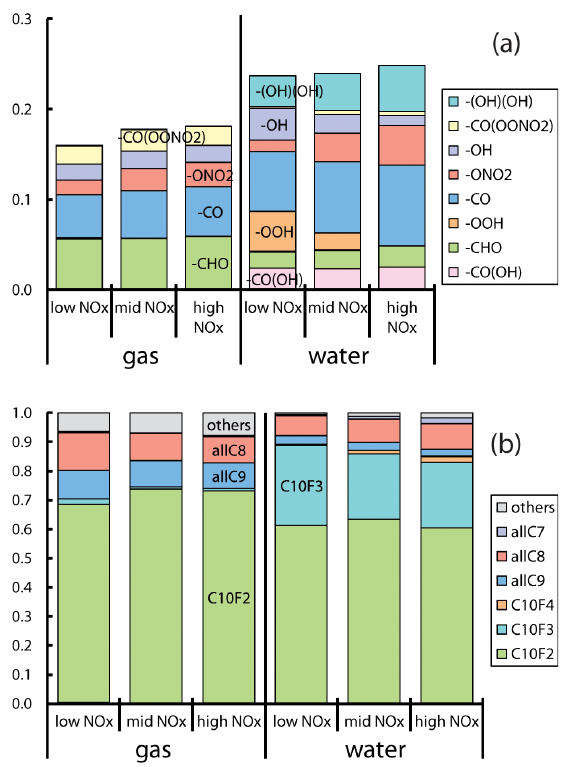
Fig. 5. At N τ = 2, simulated distribution in gaseous and aqueous phase of organic moieties ratio ( R OF / C , panel a ) and functional- ization (panel b ) for a cloud water content during the oxidation of α -pinene. C m F n category merges species with m carbon atoms bearing n functional groups. The precursor and C 1 –C 6 species are lumped in the others